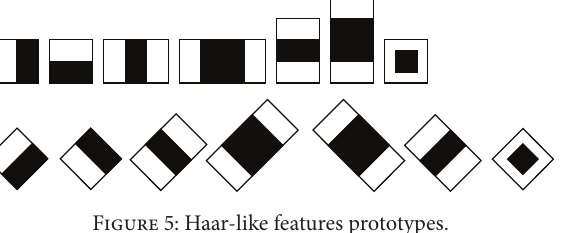
Figure 5: Haar-like features prototypes.